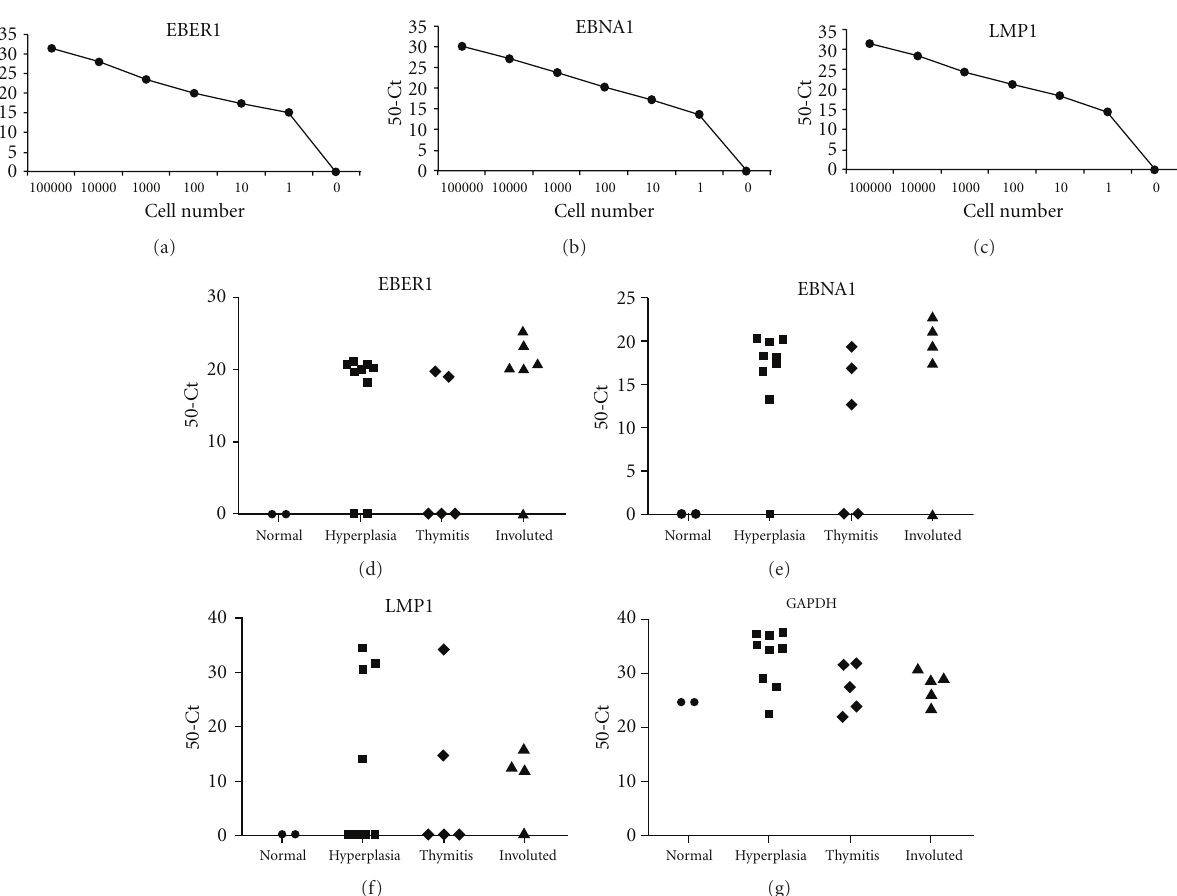
Figure 4: Real-time RT-PCR for the detection of latent EBER1, EBNA1, and LMP1 transcripts. (a, b, c) Analysis of sensitivity of the assay for EBER1 (a), EBNA1 (b), and LMP1 (c) showed that the three EBV latent transcripts could be detected in RNA extracted from a single JY EBV-infected cell. (d, e, f, g) EBER1 (d), EBNA1 (e), and LMP1 (f) were detected in most of the examined MG thymuses but not in normal control thymuses. All MG and control thymuses analysed showed high signals for endogenous control GAPDH amplification (g). Real-time RT-PCR was performed for 50 cycles, and results are expressed as 50-Ct.